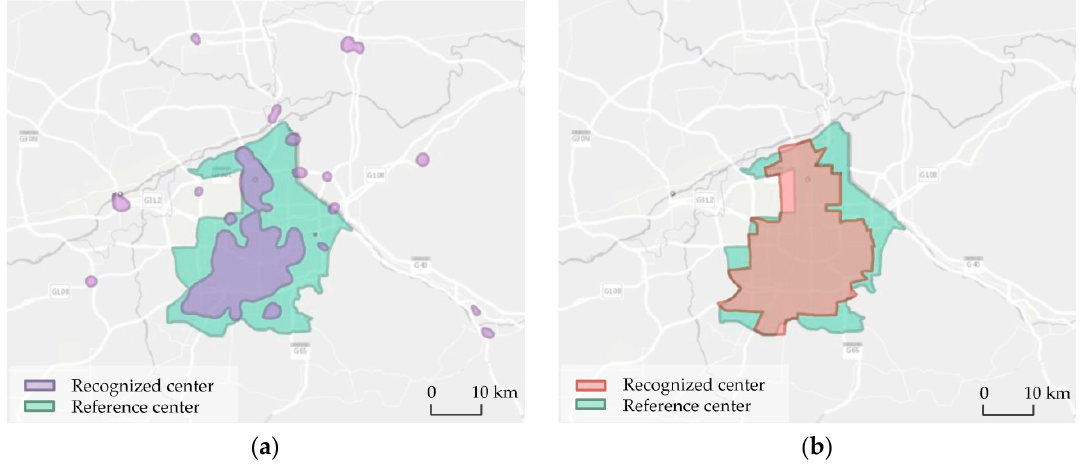
Figure 15. ( a ) The overlay diagram of the recognized center by contrast method and the reference center; ( b ) the overlay diagram of the recognized center by proposed method and the reference center.